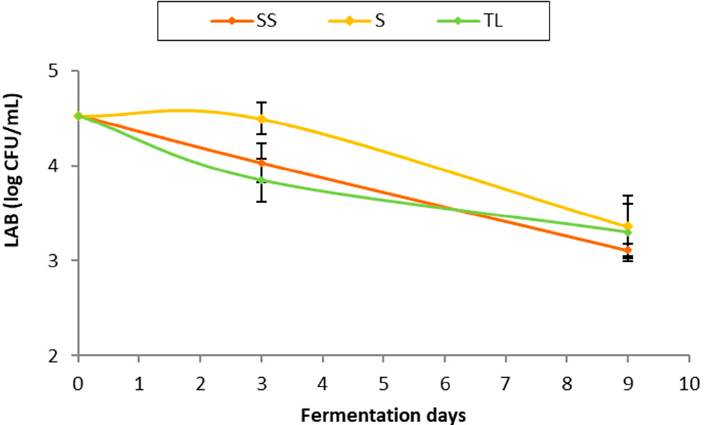
Figure 4. LAB population (log CFU/mL) throughout AF in the different inoculation strategies (SS: spontaneous sulfite, S: spontaneous without SO 2 , TL: inoculation with T. delbrueckii / L. thermotolerans at vatting without SO 2 ).